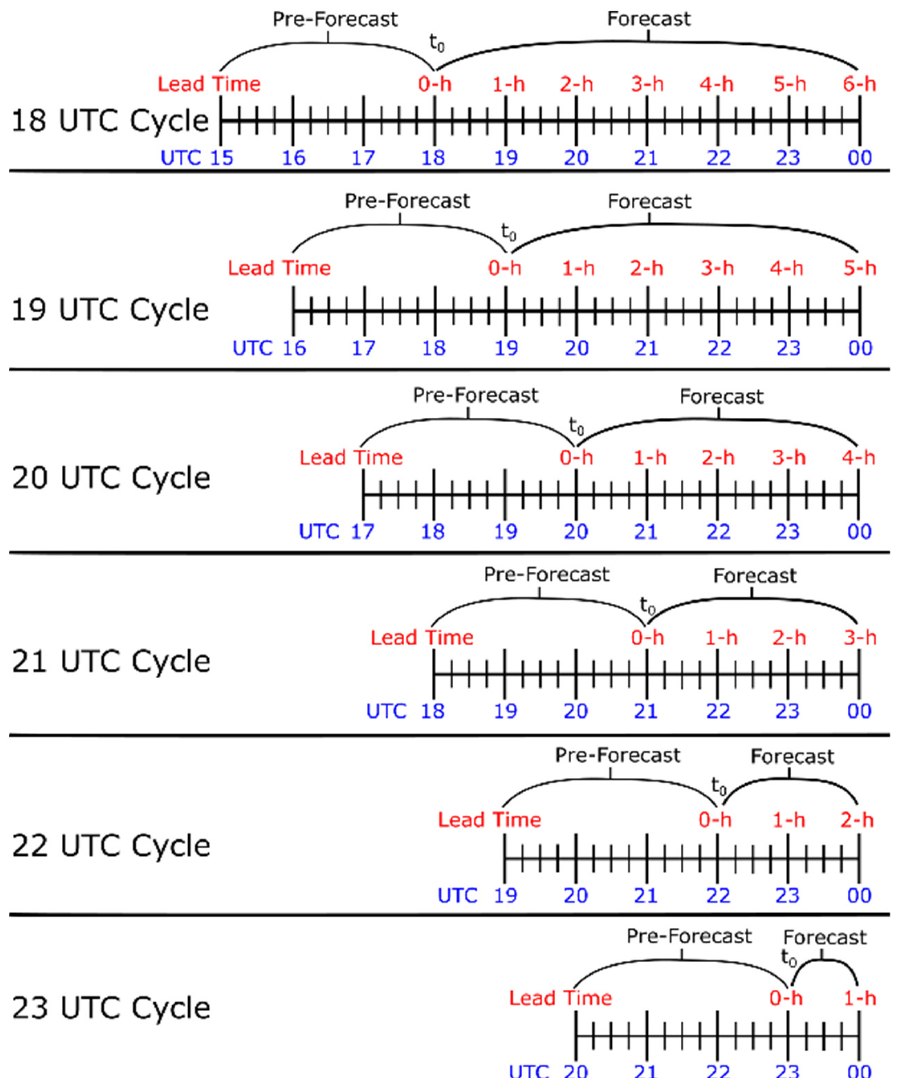
Figure 4. Illustration of the six WRF cycles used for each experiment and which are referred to by the 0 h forecast time (t 0 ). As shown in Figure 3, the 3 h pre-forecast period wherein any analysis or observation nudging data assimilation was applied is omitted in some experiments (HRRR0 and VLAPS0). The hourly forecast lead times for each cycle are labeled in red; the output was created at a 15 min temporal spacing.